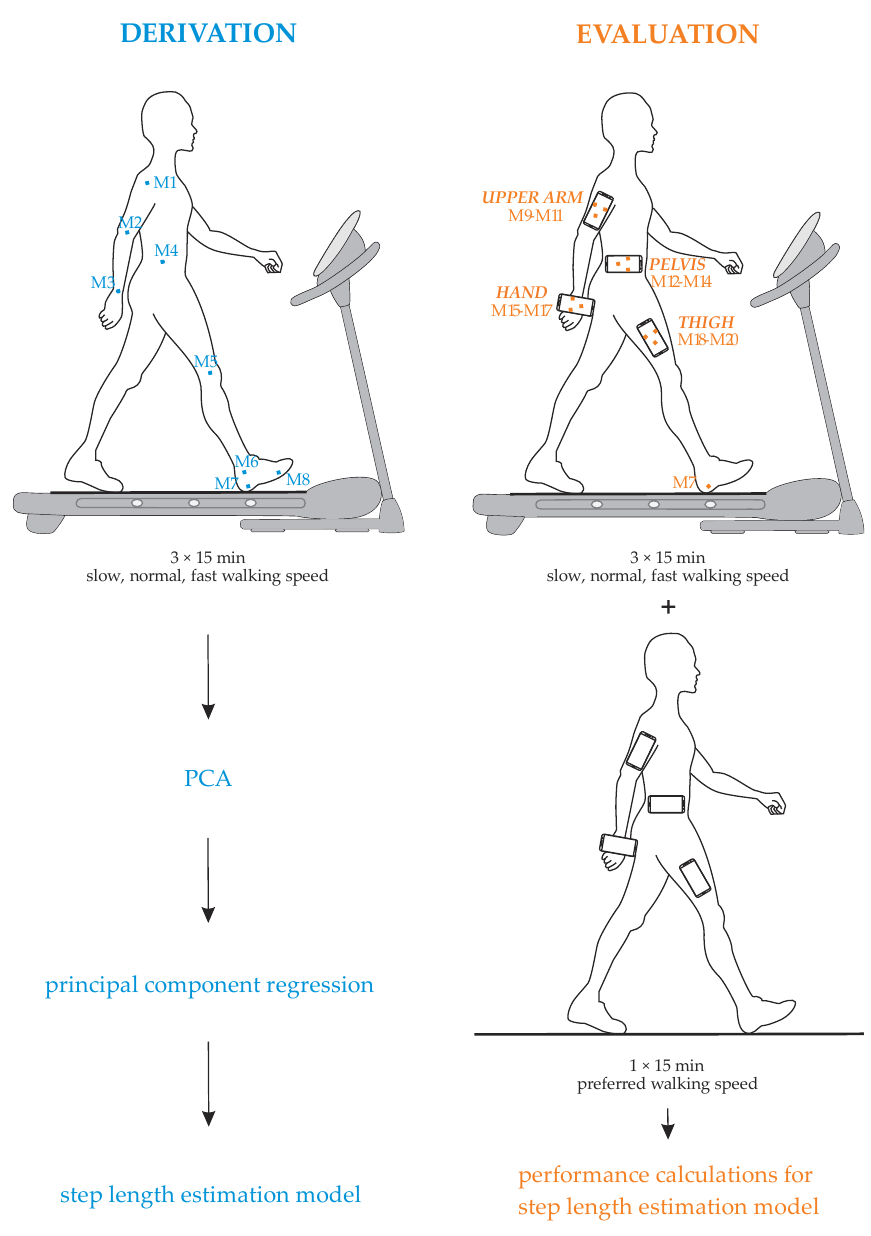
Figure 1. Design of the study for the derivation and evaluation of the step length estimation model.